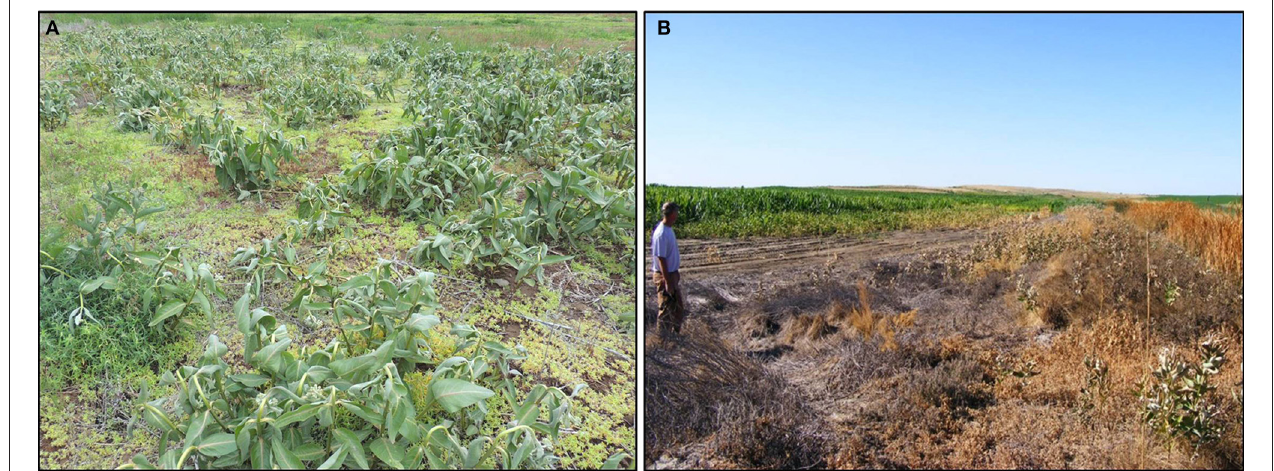
FIGURE 10 | Herbicide use targeting milkweed observed in (A) Lemhi County, Idaho, and (B) Franklin County, Washington. Applications occurred in July during peak monarch breeding activity in the study